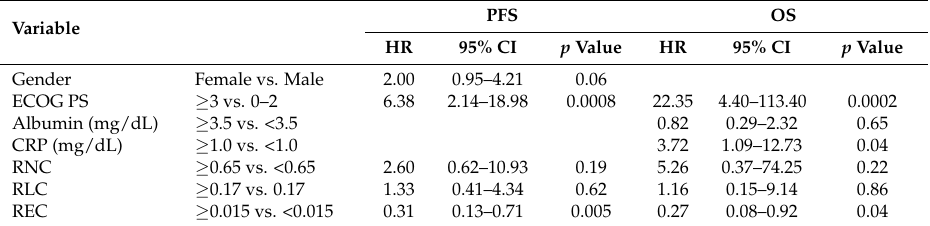
Figure 2. Survival curves in patients treated with nivolumab, stratified by the REC, PS and clinical stage: ( A , C , E ) progression-free survival; and ( B , D , F ) overall survival. REC, relative eosinophil count; PS, performance status. Table 3. Multivariate analysis of PFS and